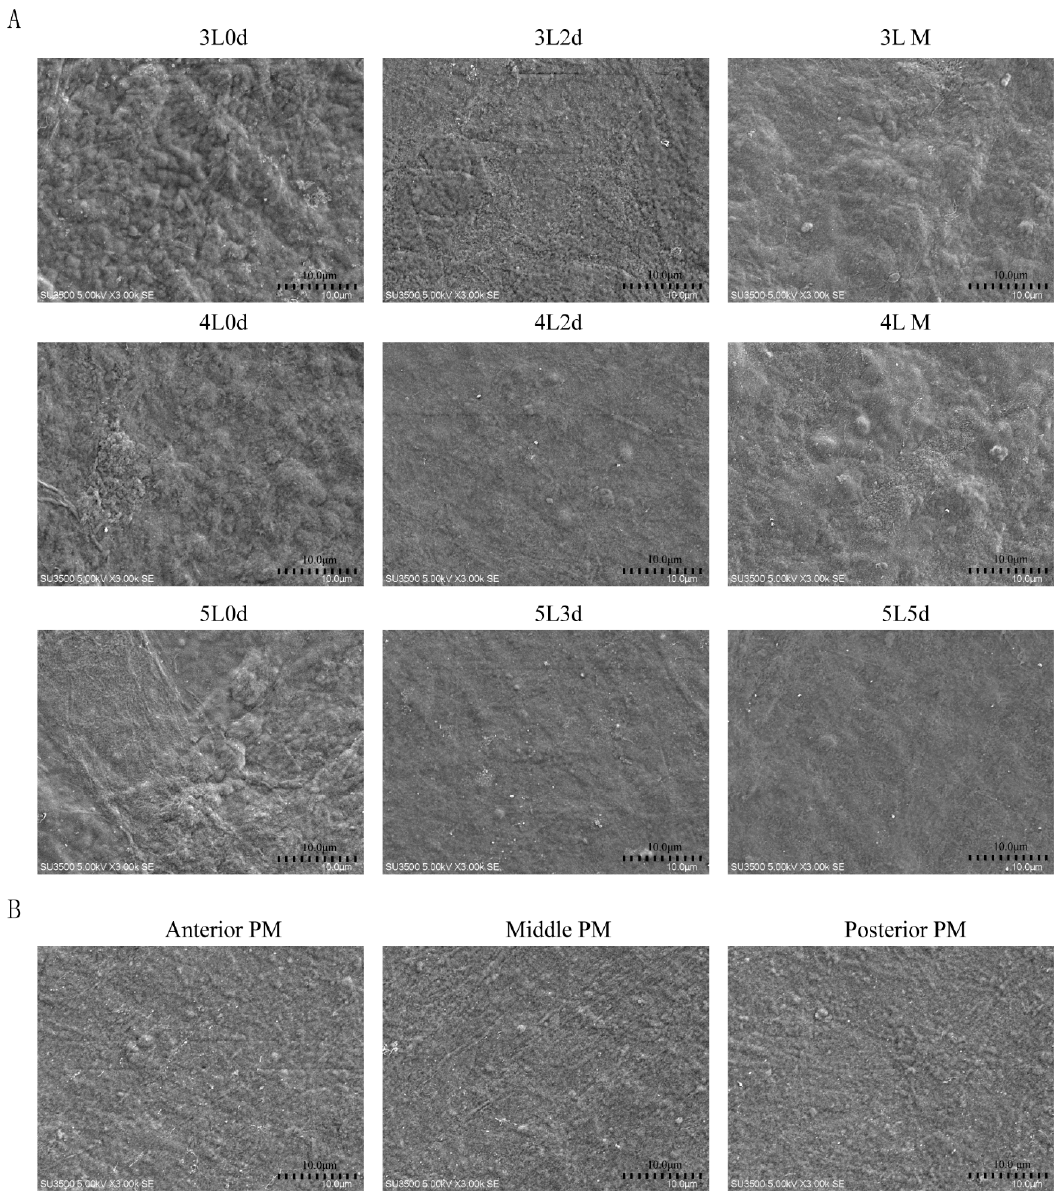
Figure 2. Morphological characterization of the lumen side of the peritrophic matrix (PM) in silkworm was observed by scanning electron microscopy. ( A ) Morphological variation of the middle PM in different development stages of silkworm (3000×). nL, instar of larval stage “n”; M, Molt; nd, Day ”n”. ( B ) Morphological characterization of anterior, middle, and posterior PM on the 3rd day of the fifth instar larvae (3000×).